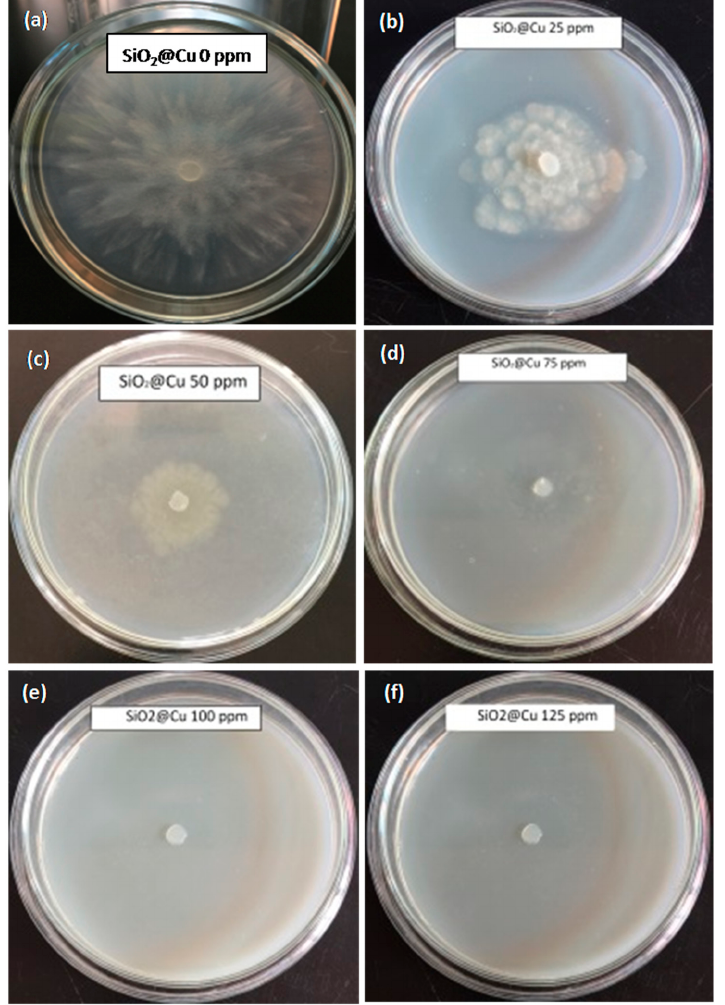
Figure 7. Mycelial growth of P. capsici after 72 h of incubation on potato dextrose agar (PDA) added by different concen- trations of SiO 2 @Cu ( a ) 0 ppm, ( b ) 25 ppm, ( c ) 50 ppm, ( d ) 75 ppm, ( e ) 100 ppm, ( f ) 125 ppm.